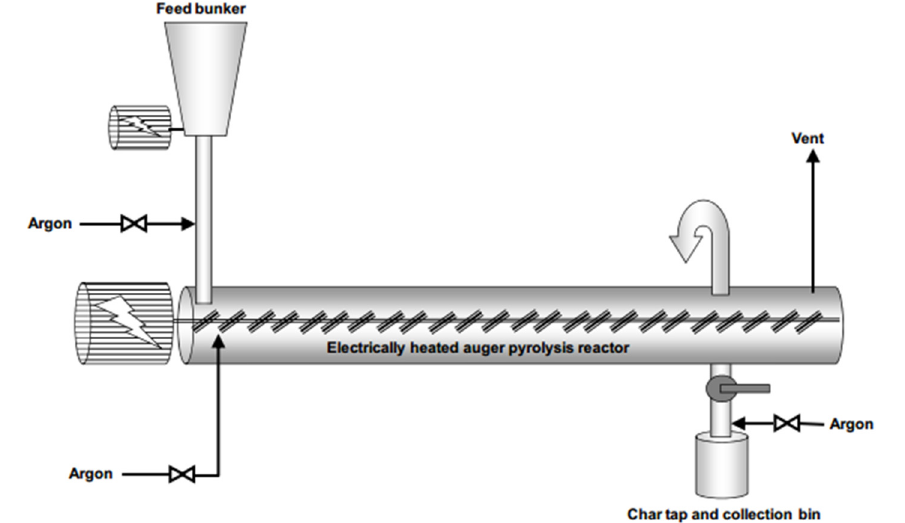
Figure 1. Schematic Layout of Pyromaat Auger Pyrolysis Reactor at Energy Research Centre of the Netherlands